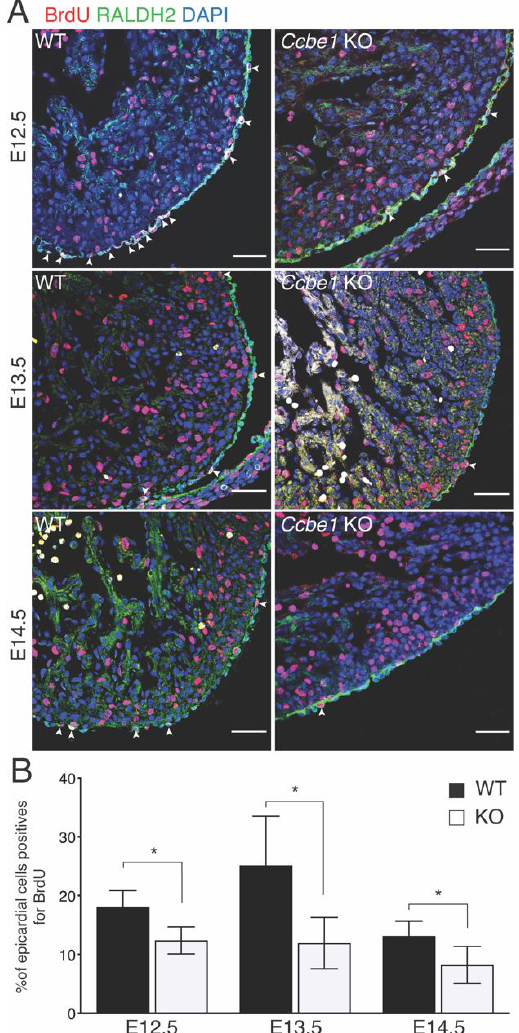
Figure 3. Ccbe1 tm1Lex mice show less epicardial cell proliferation. ( A ) Transverse sections of E12.5 E13.5 and E14.5 wild-type and Ccbe1 mutant hearts treated with BrdU, immunostained for BrdU, and RALDH2 to reveal proliferating epicardial cells. Arrowheads indicate BrdU + epicardial cells. ( B ) Quantification shows that epicardial proliferation is reduced in Ccbe1 mutant hearts. * p < 0.05. Differences were considered statistically significant when p < 0.05. Error bars represent SDs. Scale bars = 100 μm.